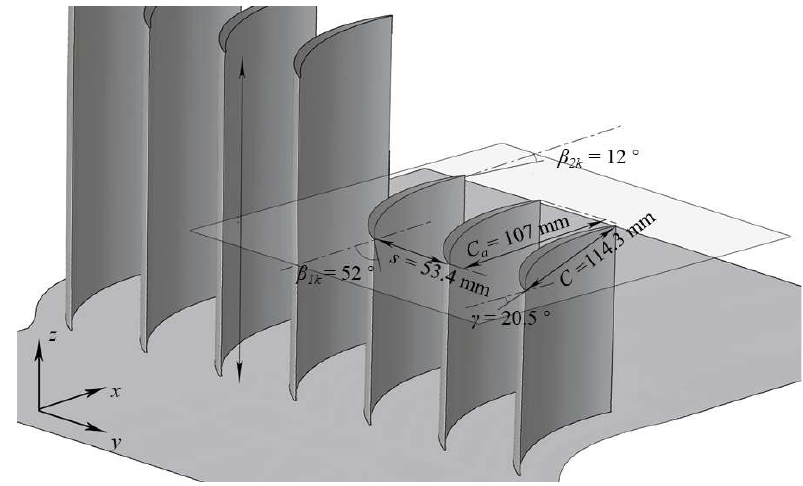
Figure 3. The geometry parameters of the baseline cascade.